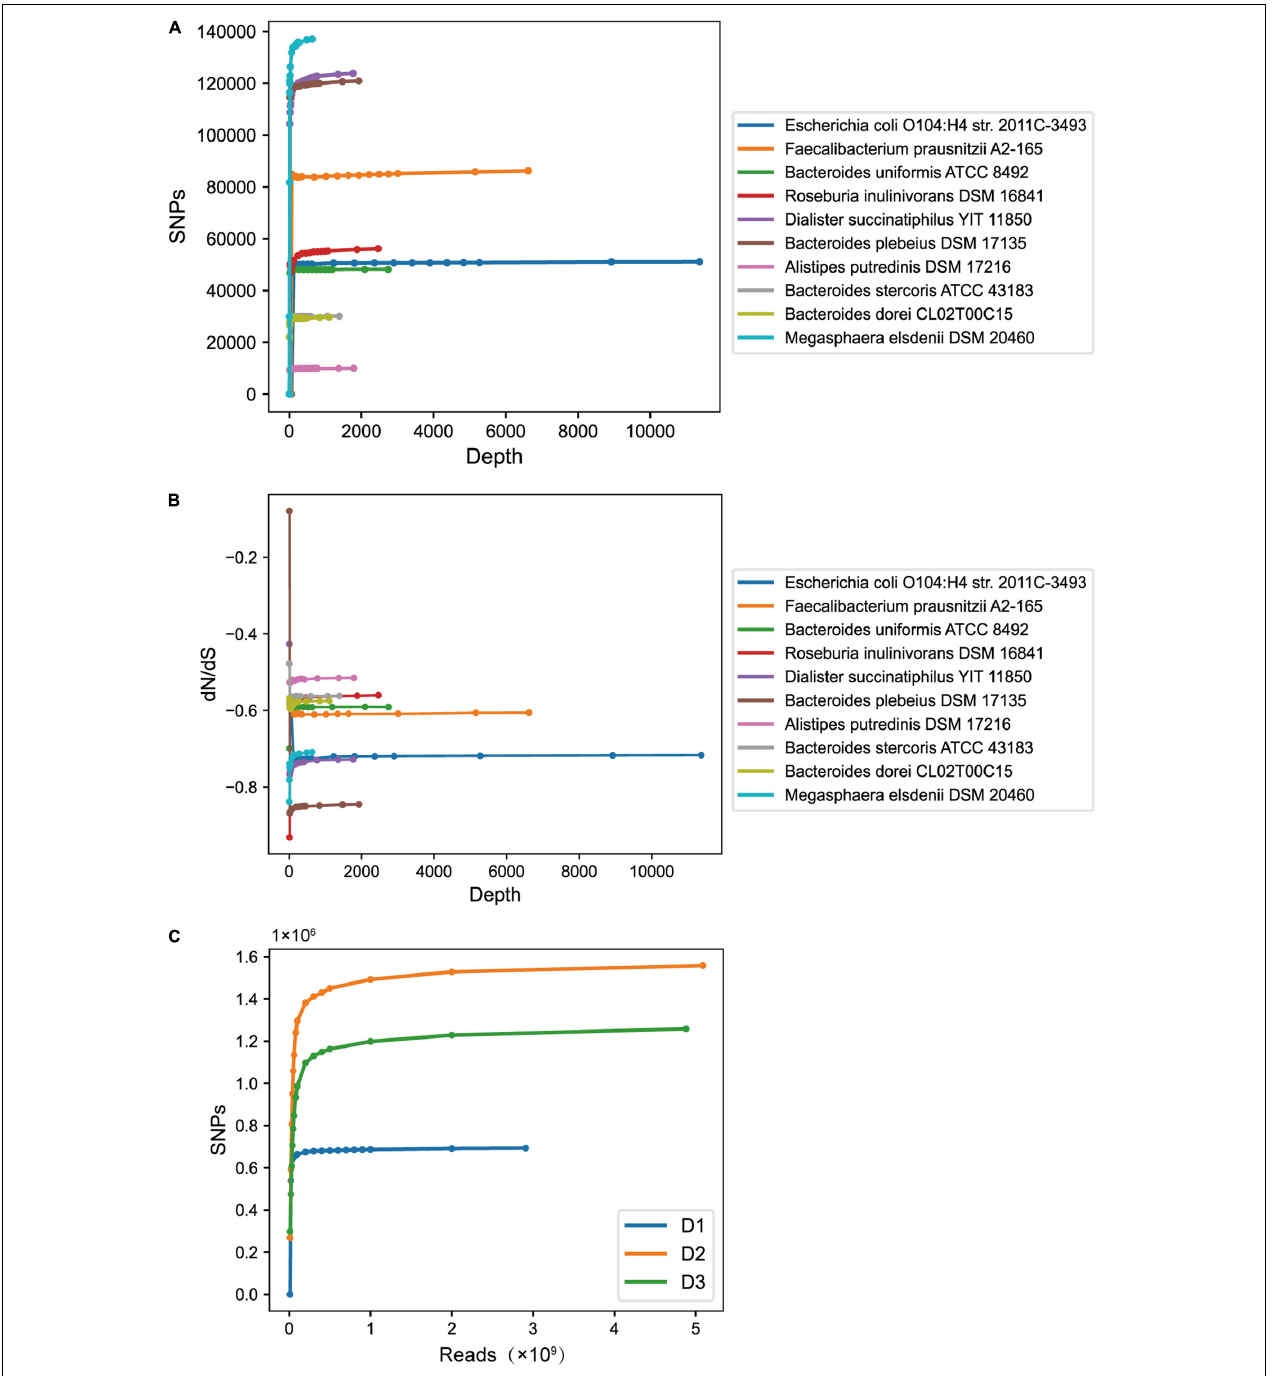
FIGURE 5 | The trend of SNP number (A) and dN/dS ratio (B) changes of dominant strains from sample D1 caused by the sequencing depth increasement. The dN/dS ratio is plotted on the log scale to show the changing trend of dN/dS more clearly. (C) The trend of cumulative SNP numbers from all dominant strains in sample level as sequencing size